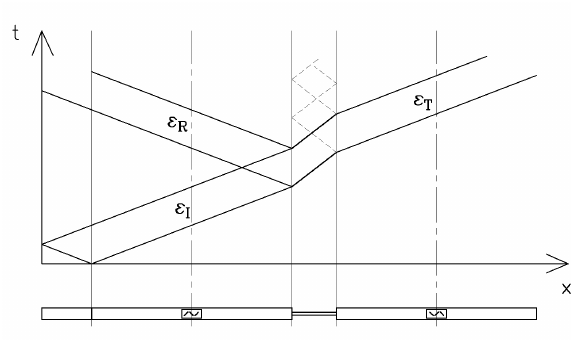
Figure 3. Space-time diagram of the wave